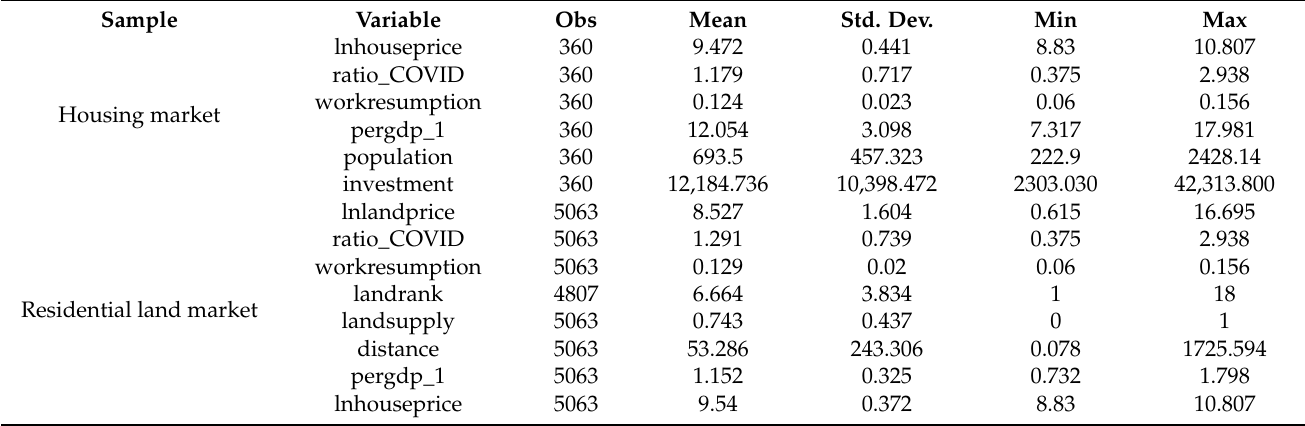
Table 1. Descriptive statistics of main